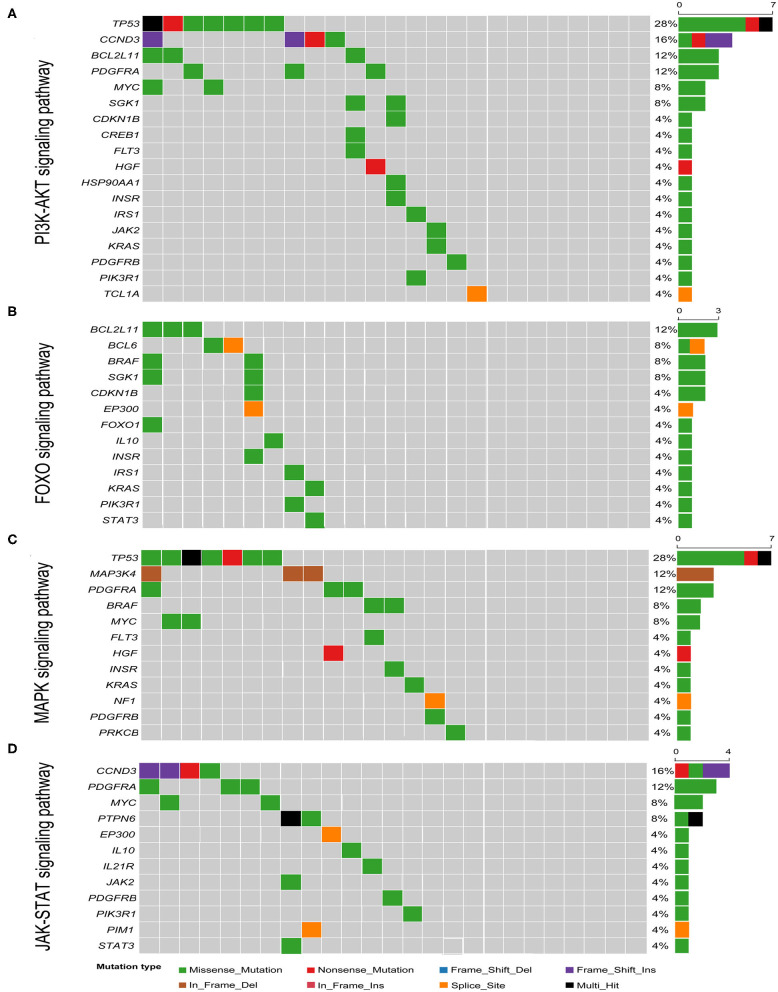
Heatmap of pathways most commonly affected by genetic mutations in GI-DLBCL. (A) PI3K-AKT signaling pathway; (B) FOXO signaling pathway; (C) MAPK signaling pathway; (D) JAK-STAT signaling pathway. Right: histogram shows the number of mutations in each gene. Percentages represent the fraction of tumors with at least one mutation in the specified gene.